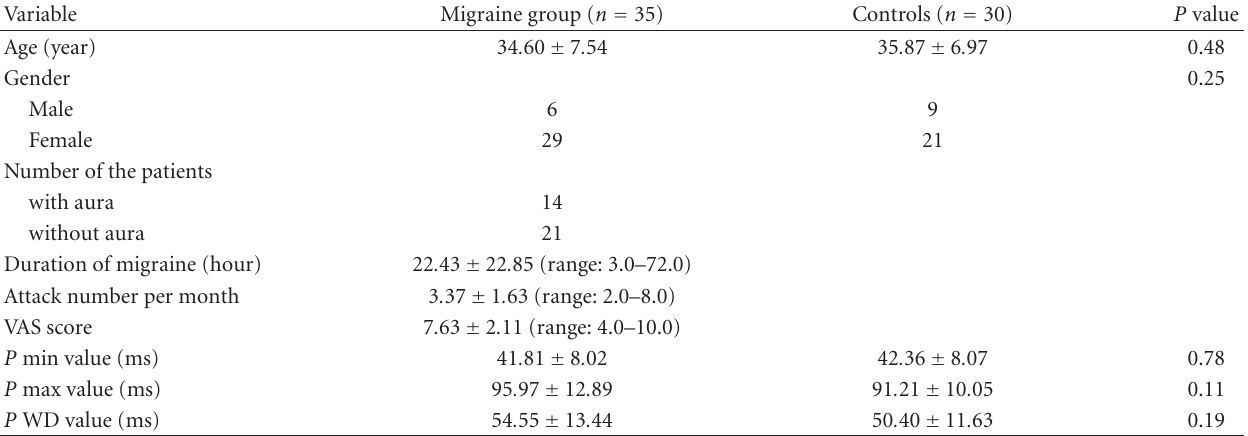
Table 1: Sociodemographical and clinical variables and P -wave durations in